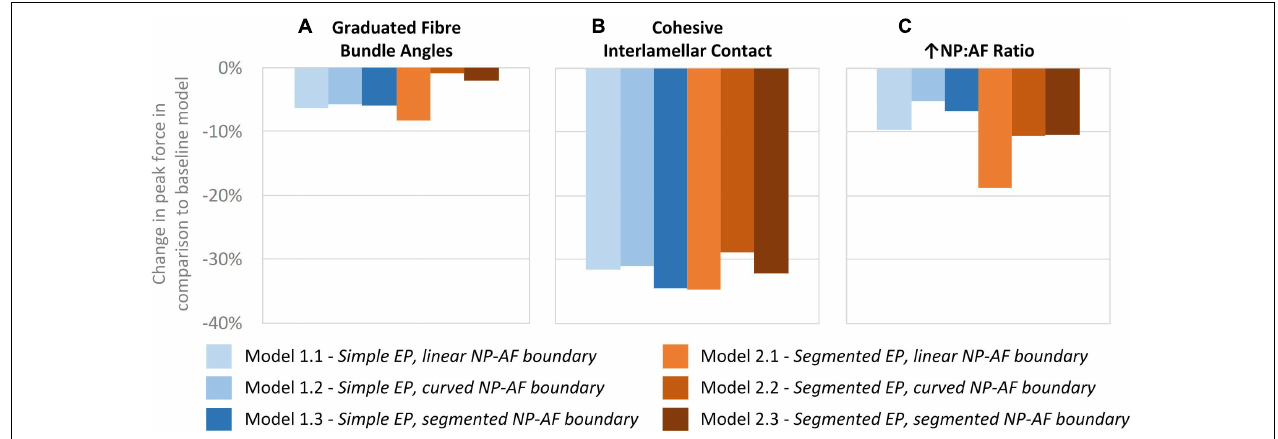
FIGURE 7 | Percentage changes in peak force compared to baseline models after (A) graduating the fibre bundle angles, (B) cohesive inter-lamellar contact, and (C) increasing the NP:AF